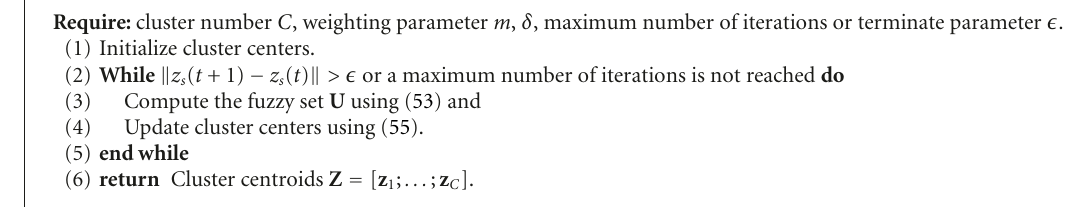
Algorithm 2: LL p -based noise clustering